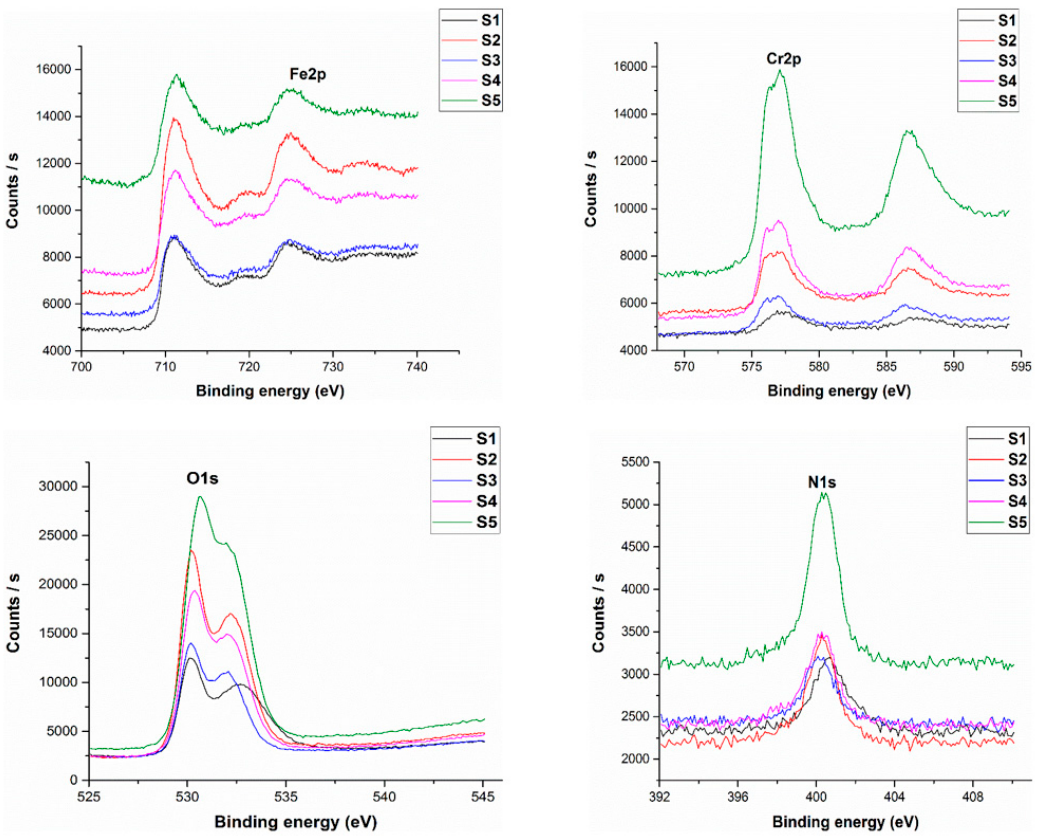
Figure 6. XPS spectra for Fe2p, Cr2p, O1s and N1s of all sintered samples.